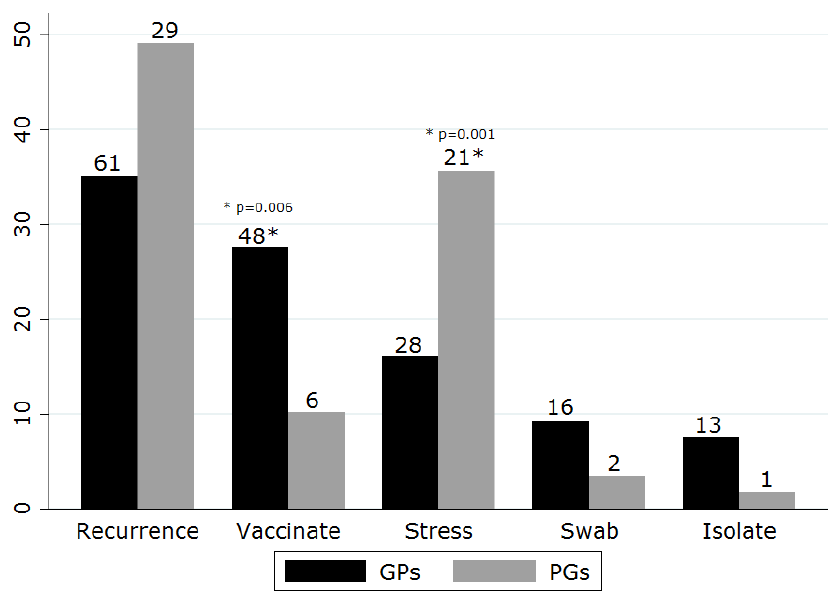
Figure 4. Additional recommendations for FHV ‐ 1 keratitis as nominated by general practitioners and postgraduate groups based in the UK in a questionnaire ‐ based survey (Recurrence, discussed likelihood of recurrence; Vaccinate, discussed need for regular vaccination; Stress, discussed stress/environmental triggers; Swab diagnostics, recommended submission of ophthalmic swab for diagnostic testing; Isolate, discussed contagion to other cats and/or recommended